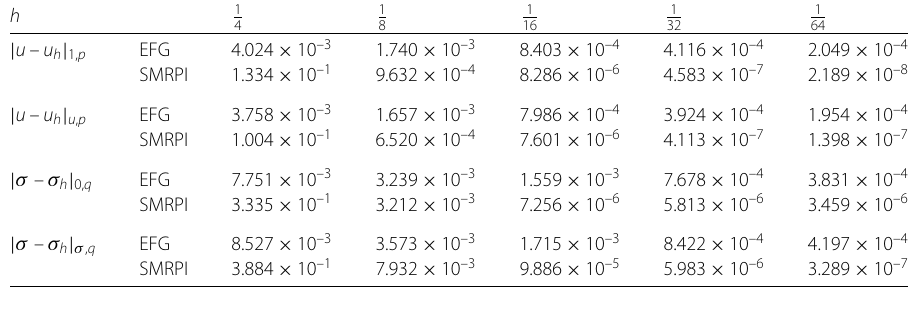
Table 1 Comparing errors with different types of norms and quasi-norms for Example 1 with p = 4.0 and s = 0.6 for SMRPI and EFG methods h 1